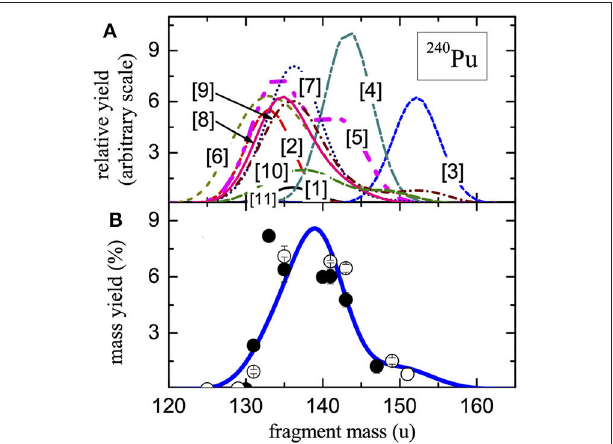
FIGURE 10 | (A) Partial mass distributions for different EFPs of Figure 9B as indicated. The distribution corresponding to the most-probable fission path, i.e., EFP 5, is shown by a thick line. (B) The mass distribution for the SF of 240 Pu obtained by counting contributions from all the Langevin trajectories, in addition to the eleven selected EFPs. The experimental data [109, 110] are shown by circles that include mirror points (open circles). Only the heavy-fragment parts are plotted in both (A,B) . The figure is partially adapted from Sadhukhan et al. [92].